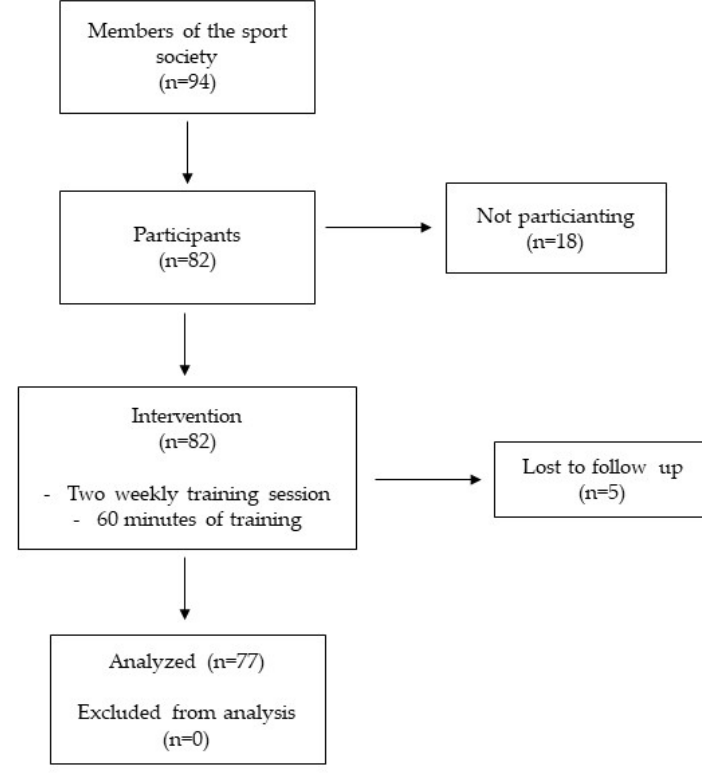
Figure 1. Flow Figure 1. Flow chart.